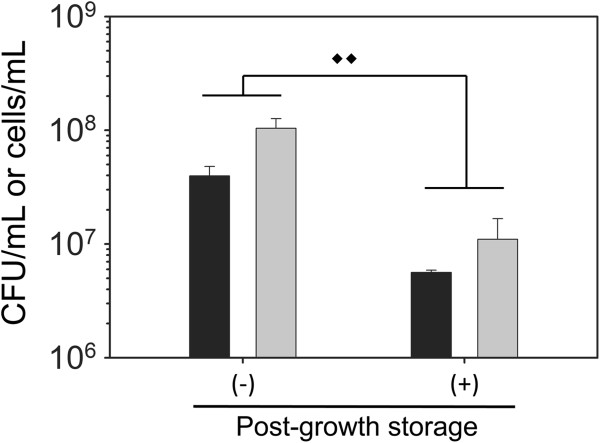
Post-growth storage of samples at 8°C for 48 h decreases final cell density. Wild-type P. aeruginosa was cultured in mAUMg containing 5 mM phosphate at 37°C for 72 h. Final cell density was measured immediately following growth (-) or following post-growth storage at 8°C for 48 h (+) by plate counting (black bars) or FCM (gray bars). For FCM samples, fixative was added immediately following growth (-) or after post-growth storage at 8°C for 48 h (+), and cells were stored at 4°C prior to staining and assessing cell numbers. Diamonds indicate results from two-way ANOVA: ♦♦p < 0.01. Error bars, SD; N = 3.